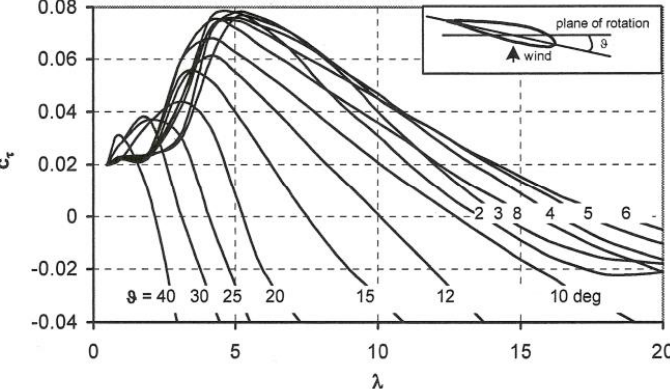
Figure 4. Torque coefficient for a specific type of turbine, with variations of λ and β .